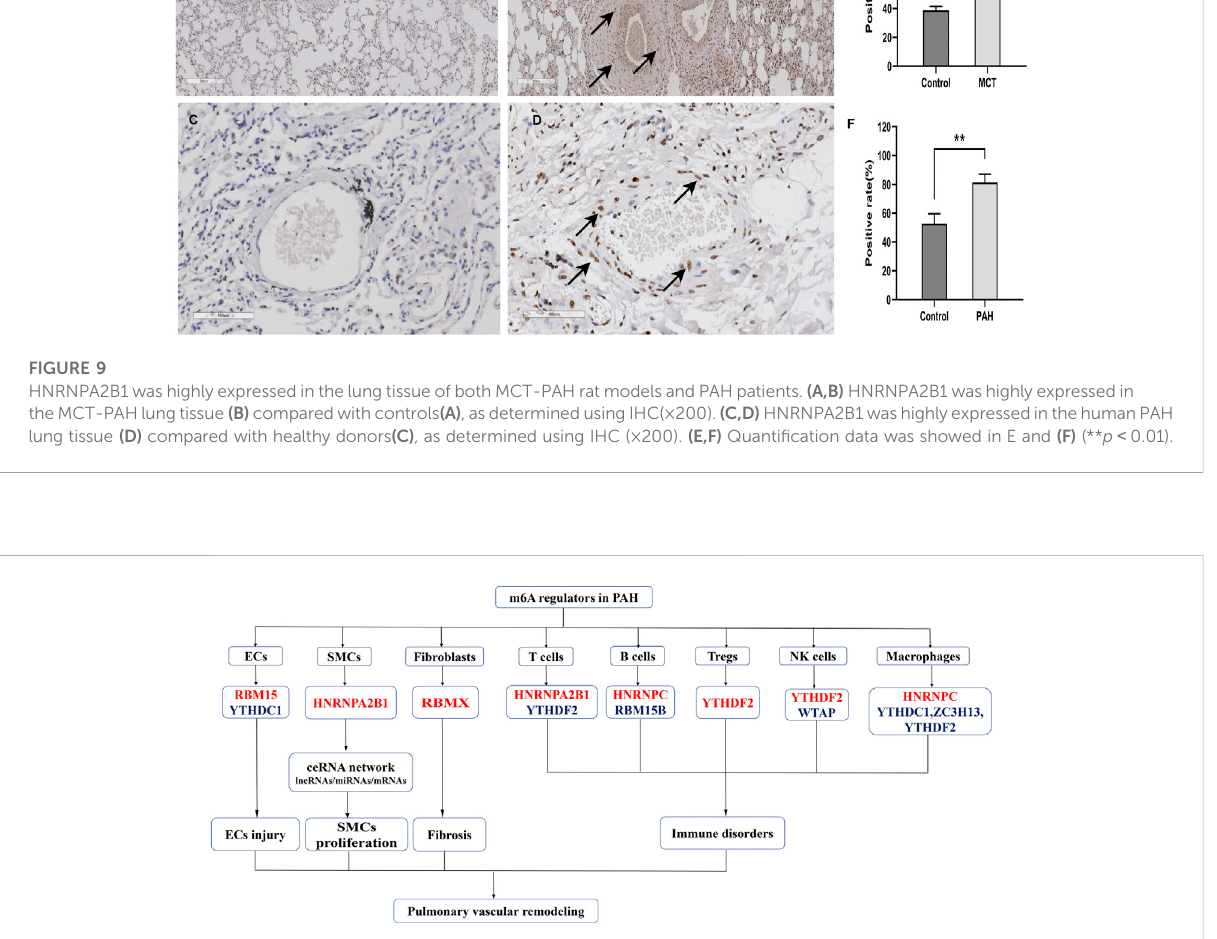
FIGURE 10 An overview of dysregulated m6A regulators and proposed mechanism of the study. Red represent the increased m6A regulators and the blue represent the decreased m6A regulators in PAH. M6A regulators promotes the phenotype switch in PASMCs proliferation, ECs injury, fi broblast activation and immune disorders leading to pulmonary vascular remodeling and PAH